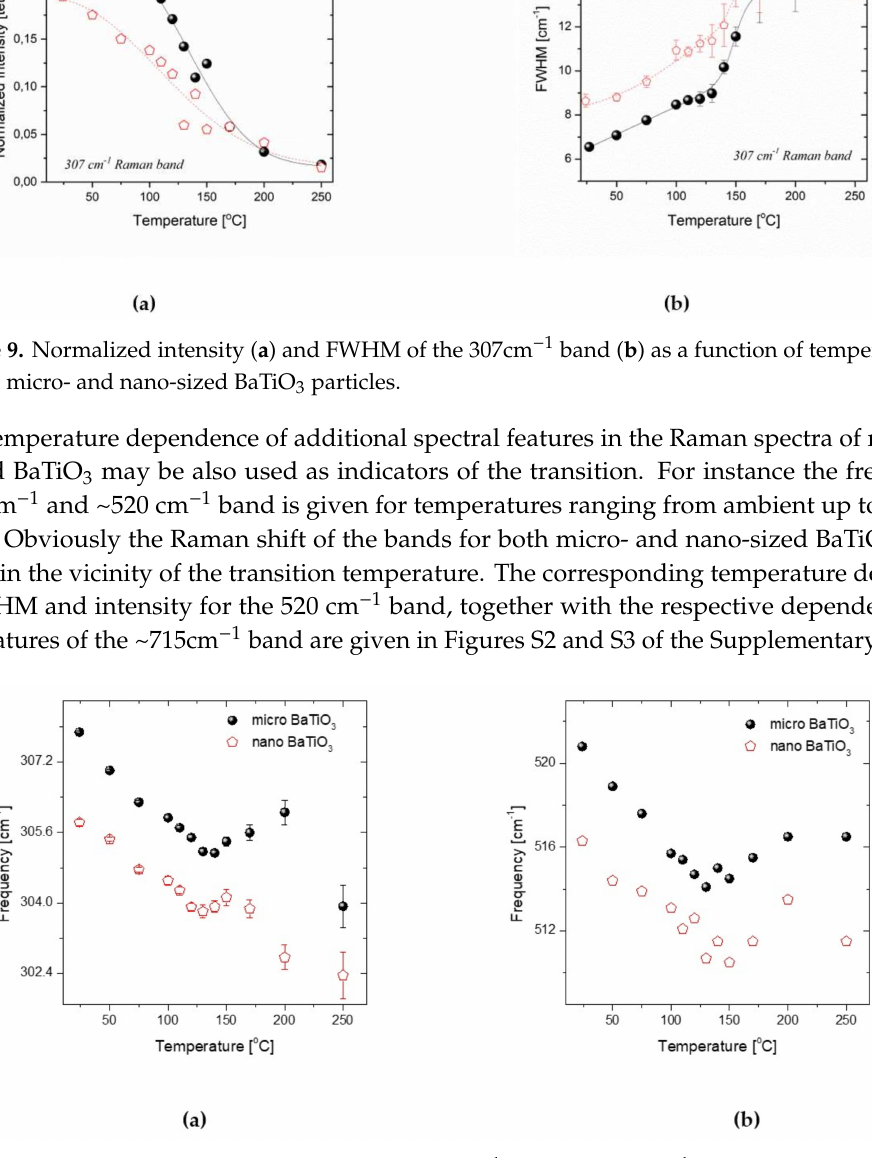
Figure 10. Temperature dependence of the ( a ) ~307 cm − 1 and ( b ) ~520 cm − 1 bands for the nano- and micro-sized BaTiO 3